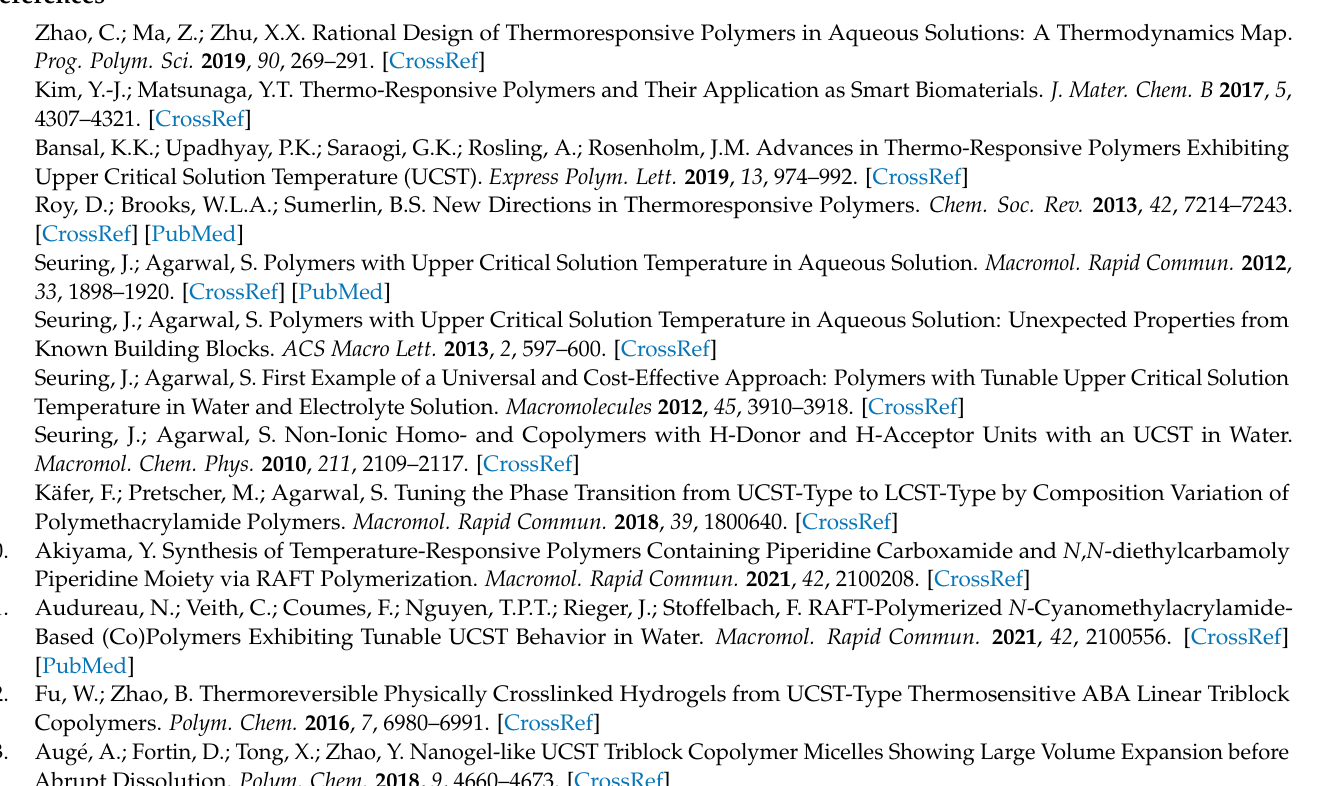
peratures; Figure S9: SAXS intensity (I) versus scattering vector (q) for PDMAm 36 - b -PCMAm 91 ( Sample 5 ) in water at 0.1 wt% at 25 ◦ C (dark blue), 70 ◦ C (red) and back to 25 ◦ C (light blue);